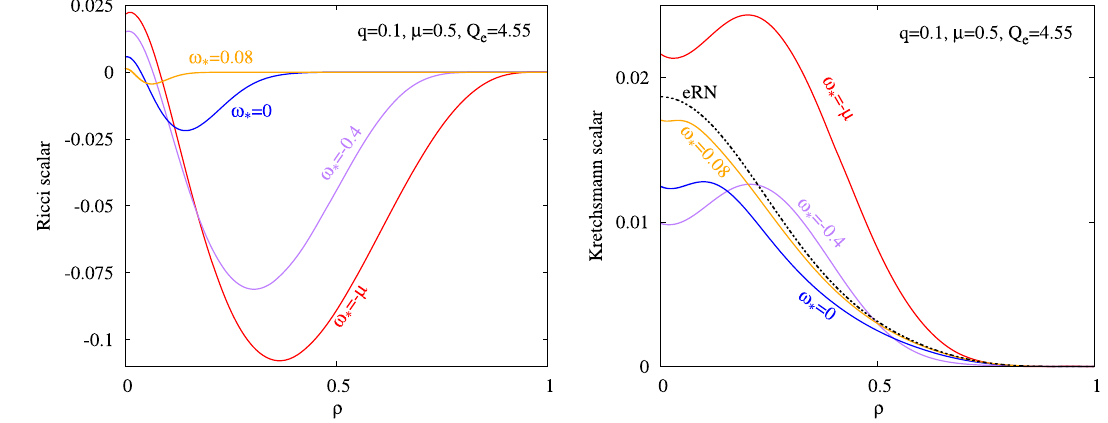
Fig. 3 Ricci scalar (left) and Kretschmann scalar (right) as a function of the compactified coordinate ρ . Each color corresponds to a solution with w ∗ = {− μ, − 0 . 4 , 0 , 0 . 08 } (red, purple, blue and orange respectively). All solutions have q = 0 . 1, μ = 0 . 5, Q